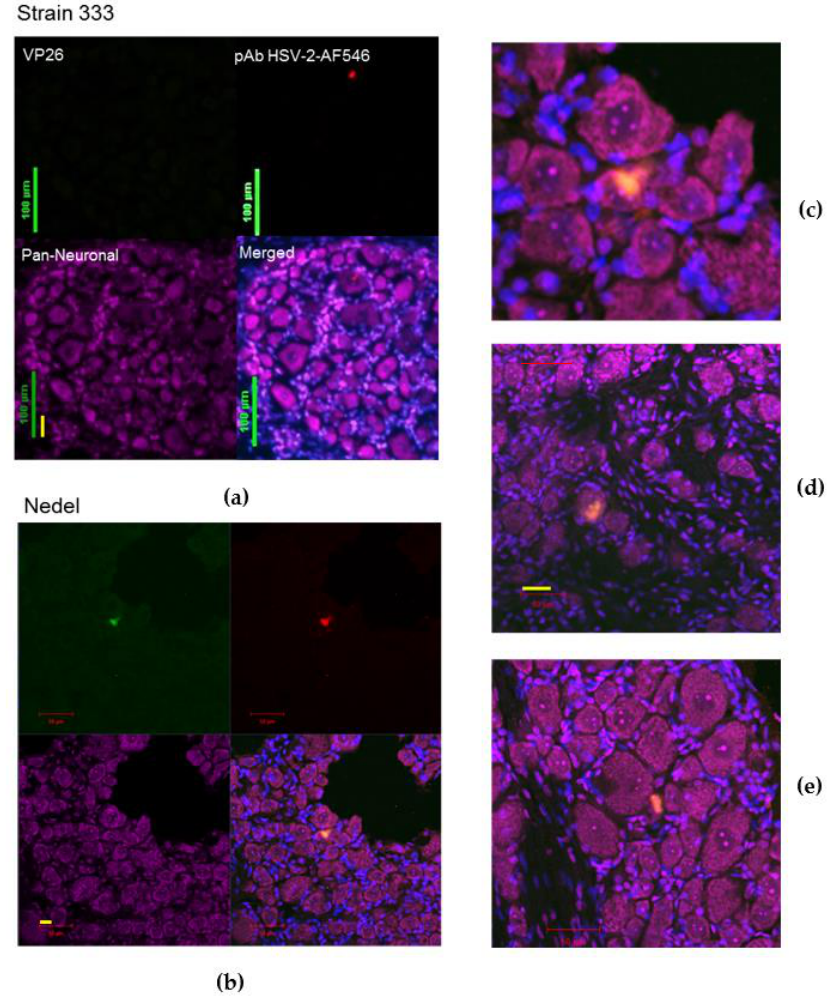
Figure 7. In Vivo Reactivation. Representative confocal microscopic images of immunolabelled cryosections of guinea pig sacral dorsal root ganglia infected with ( a ) Strain 333, green bar = 100 µm, yellow bar = 30 µm ( b ) Nedel. Upper left : Detection of mNeonGreen fluorescence, Upper right : immunofluorescence using pAb HSV-2-AF546, Lower left : Pan-neuronal stain, Lower right : Merged, ( c ) enlarged (merged) image of reactivation shown in ( b ); red bar = 25 µm. ( d ) Enlarged (merged) image of different reactivation, red bar = 50 µm, yellow bar = 33 µm. ( e ) Enlarged (merged) image of another reactivation.